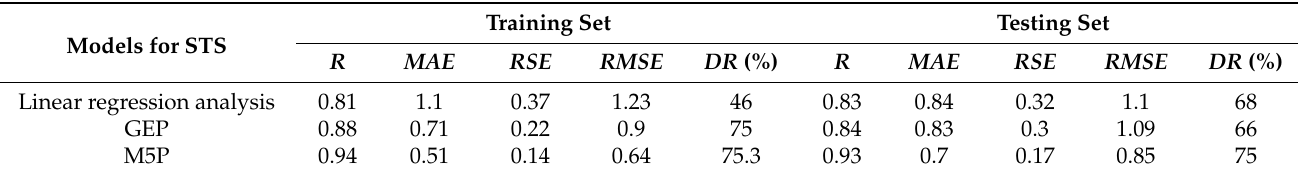
Table 6. Comparison of the different models developed for the STS database.